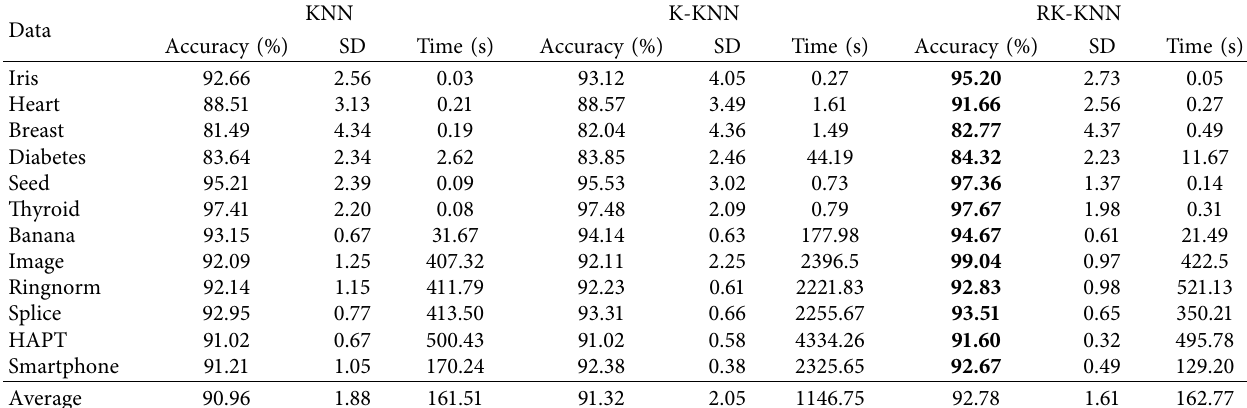
Table 2: The comparison results among three models.